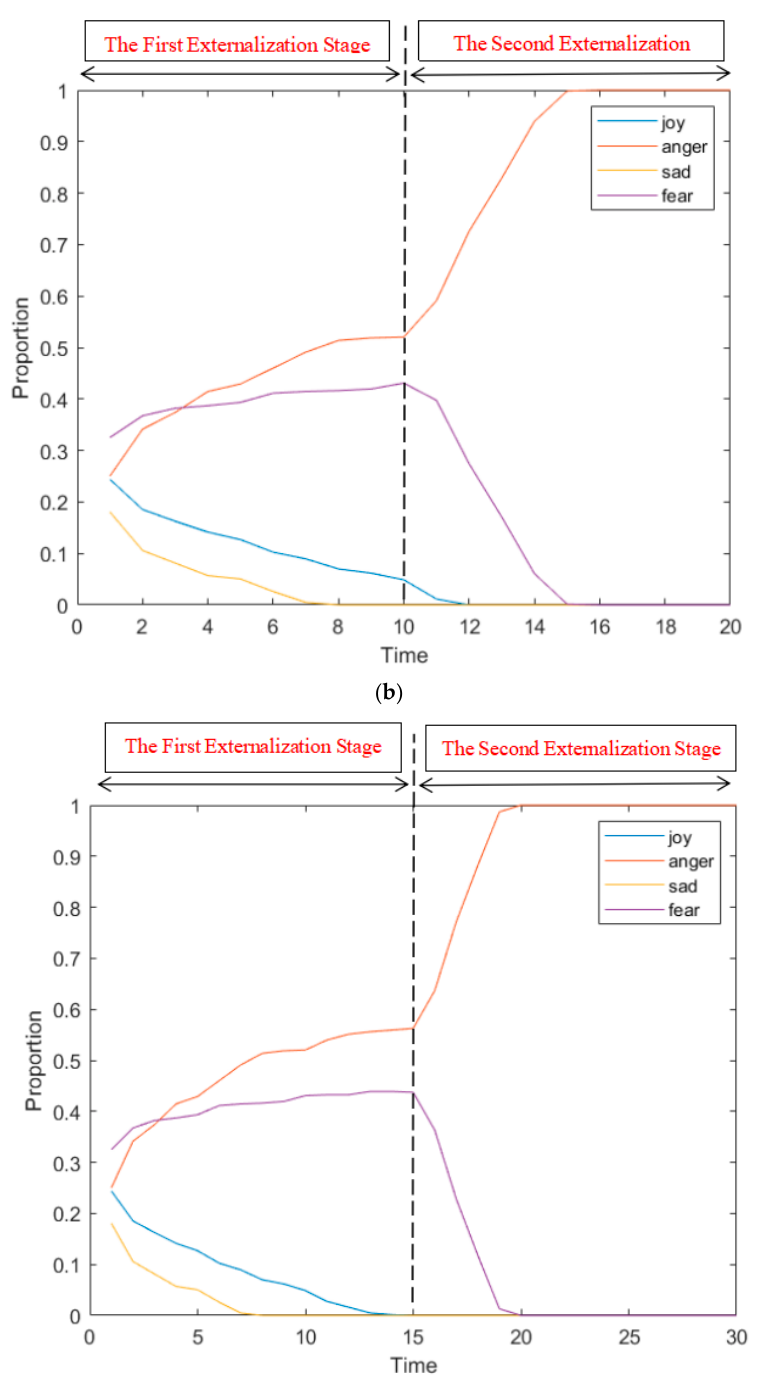
Figure 14. The curve of attitude proportion with the changes of interaction times under different t 1.